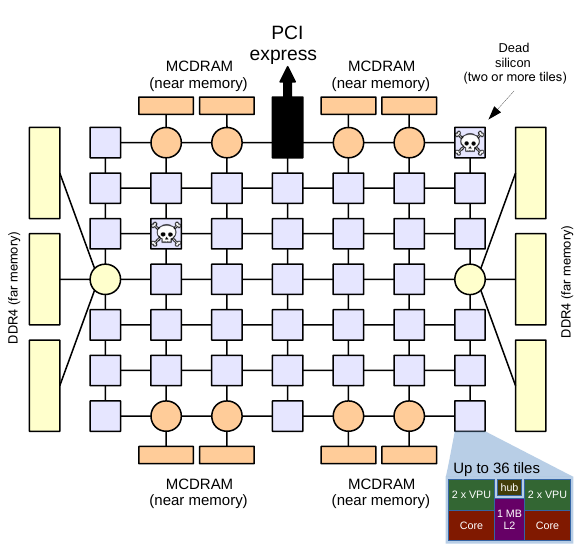
Figure 1. Architectural heterogeneity: a schematic comparison be- tween an Intel Broadwell CPU socket (two sockets to a node, joined locally by the quick path interconnect, QPI) and an Intel Knights Landing MIC node. Notable differences include the two- dimensional mesh linking cores and memory (near and far) on the MIC node (with up to 16GB of near memory L3 cache) and the bidirectional full ring on the CPU linking the cores (and support- ing up to 50MB shared L3 cache). The most important difference, however, is the number of cores: approximately 20 to a socket or 40 to a CPU node and up to 72 on the MIC node. (Not shown in this diagram is the 256MB L2 cache in the Broadwell cores and their internal vector processing